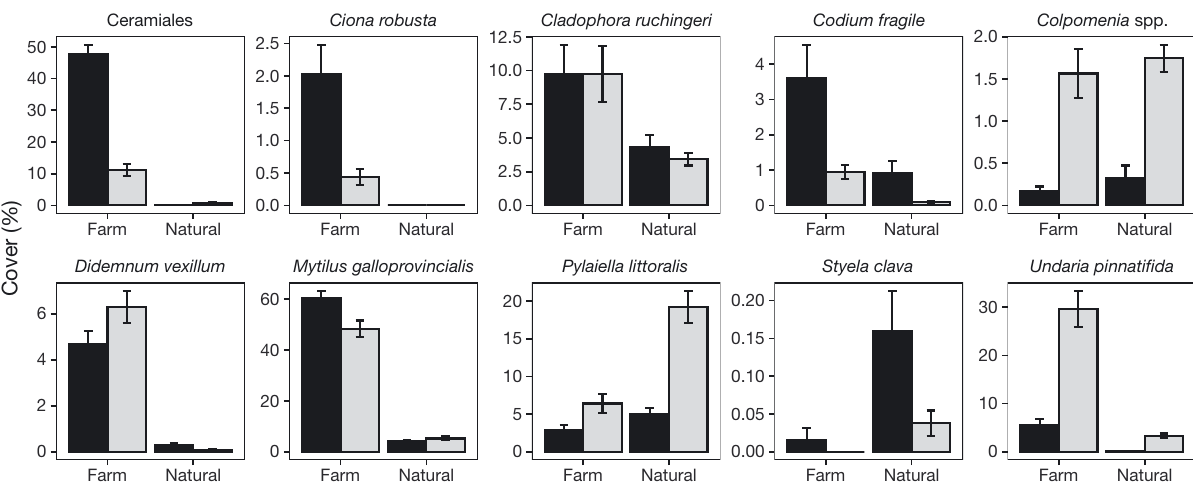
Fig. 4. Mean (±SE) percent cover for each focal taxon in relation to habitat type (farm and natural) and sampling season (summer; black bars and winter; grey